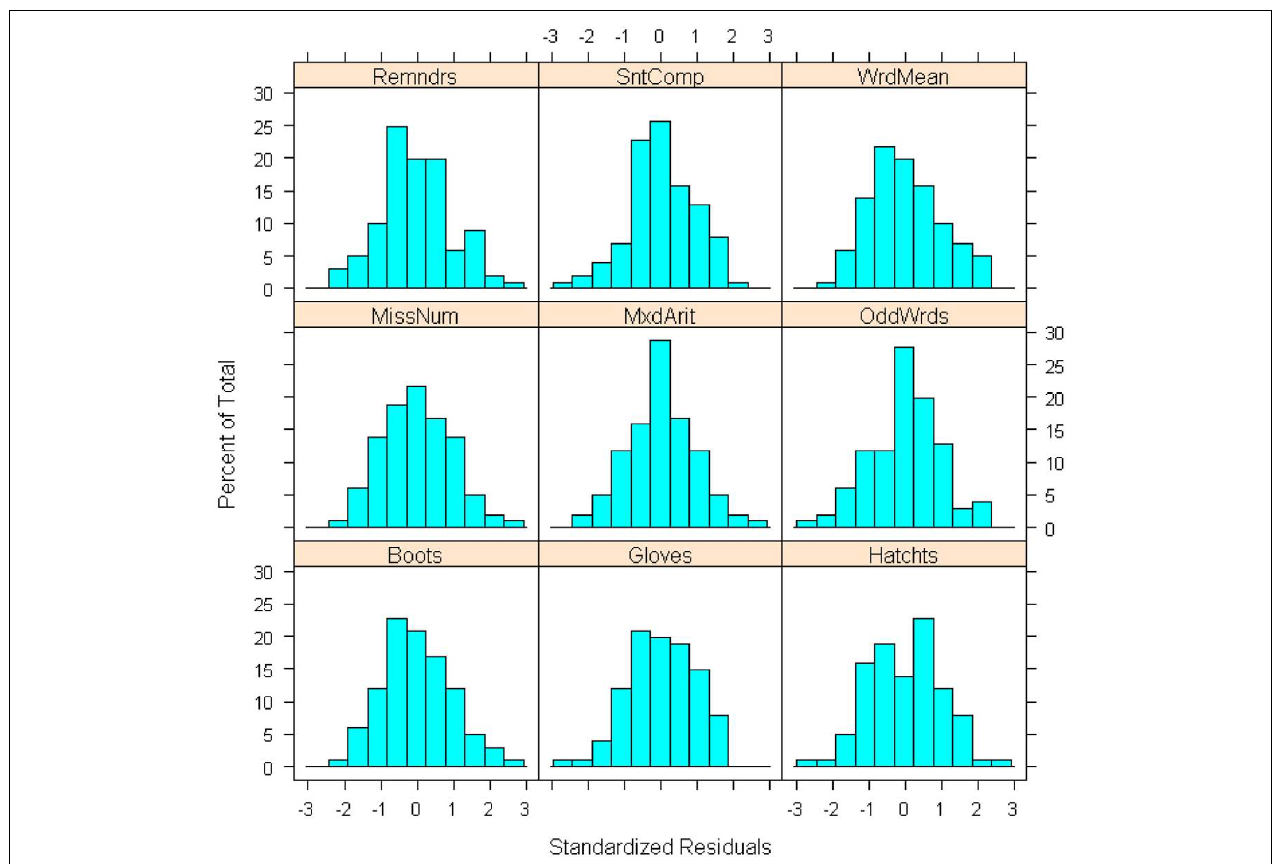
FIGURE 2 | Histograms of standardized residuals for each observed variable from three-factor model fitted to random sample data ( N = 100; no unusual cases).